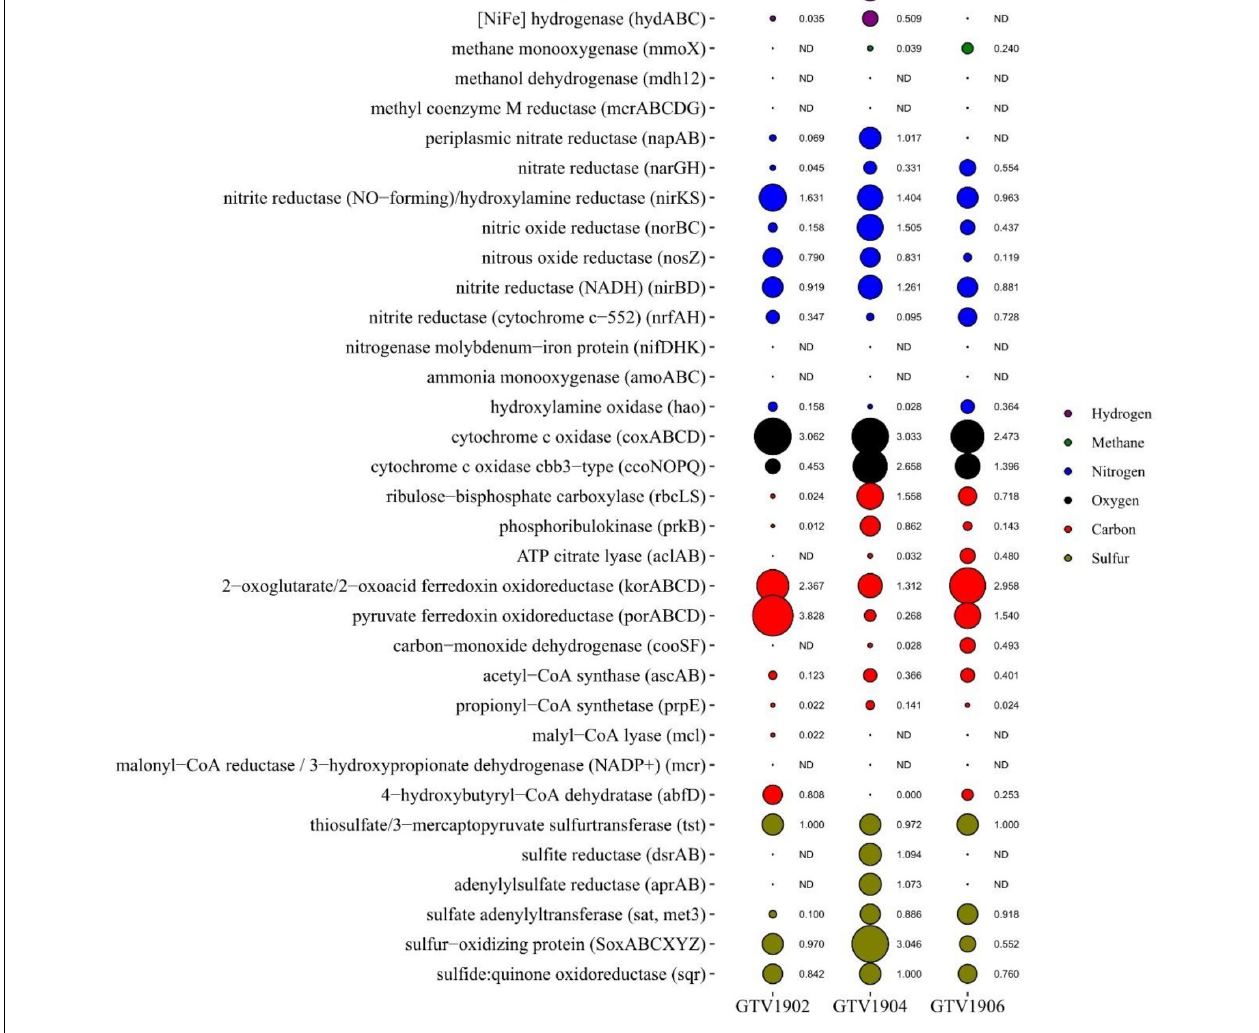
FIGURE 3 | The relative abundance of key metabolic genes involved in energy-yielding processes and carbon fixation pathways in the different metagenome assemblies. Each bubble size represents the relative abundance of specific genes against the total number of KO hits in each assembly.